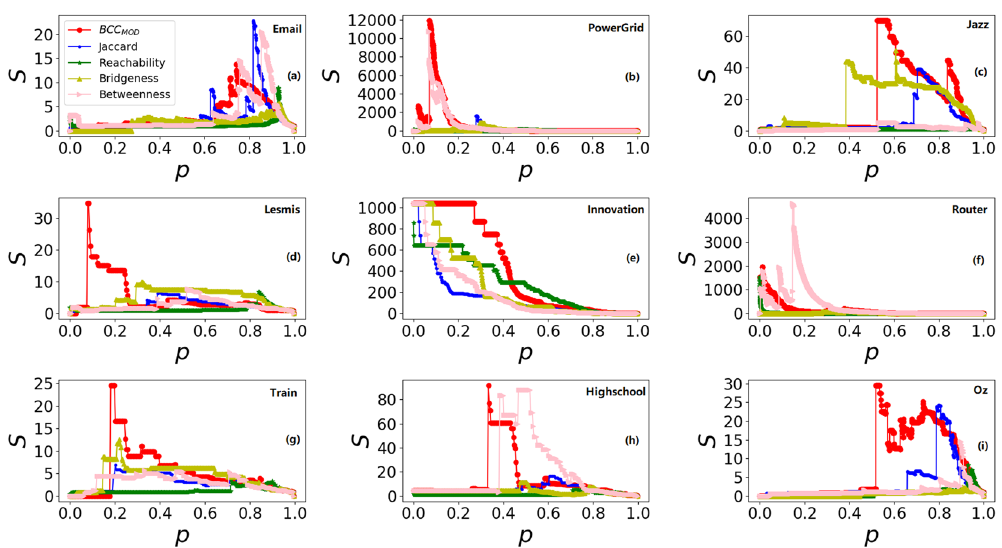
Figure 1. The susceptibility index S over different value of p